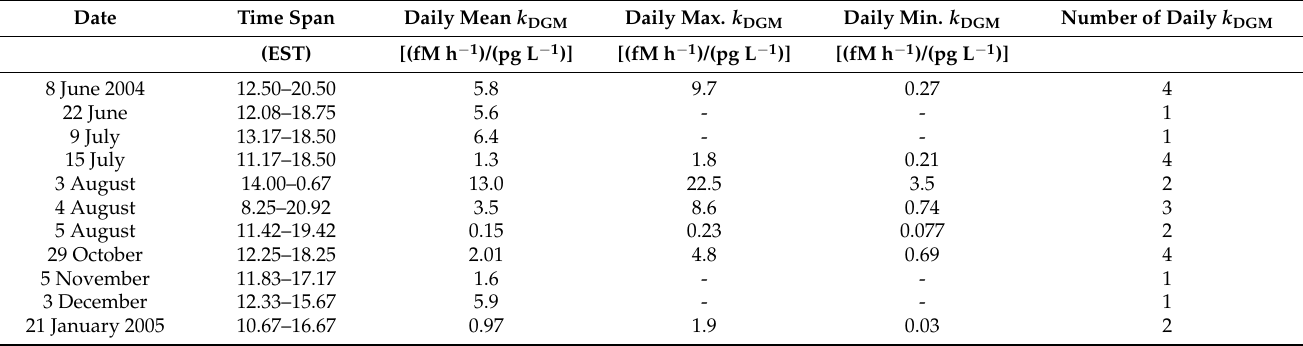
Table 2. Summary of the daily DGM production rate constant values (kDGM) calculated using the simple mass balance box